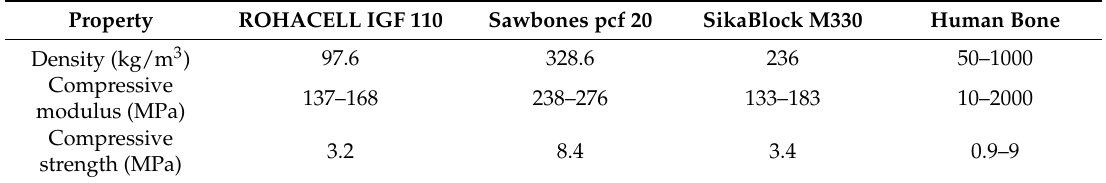
Table 2. Overview of the experimentally determined mechanical properties of artificial bone cavity materials in comparison to literature data on human bone